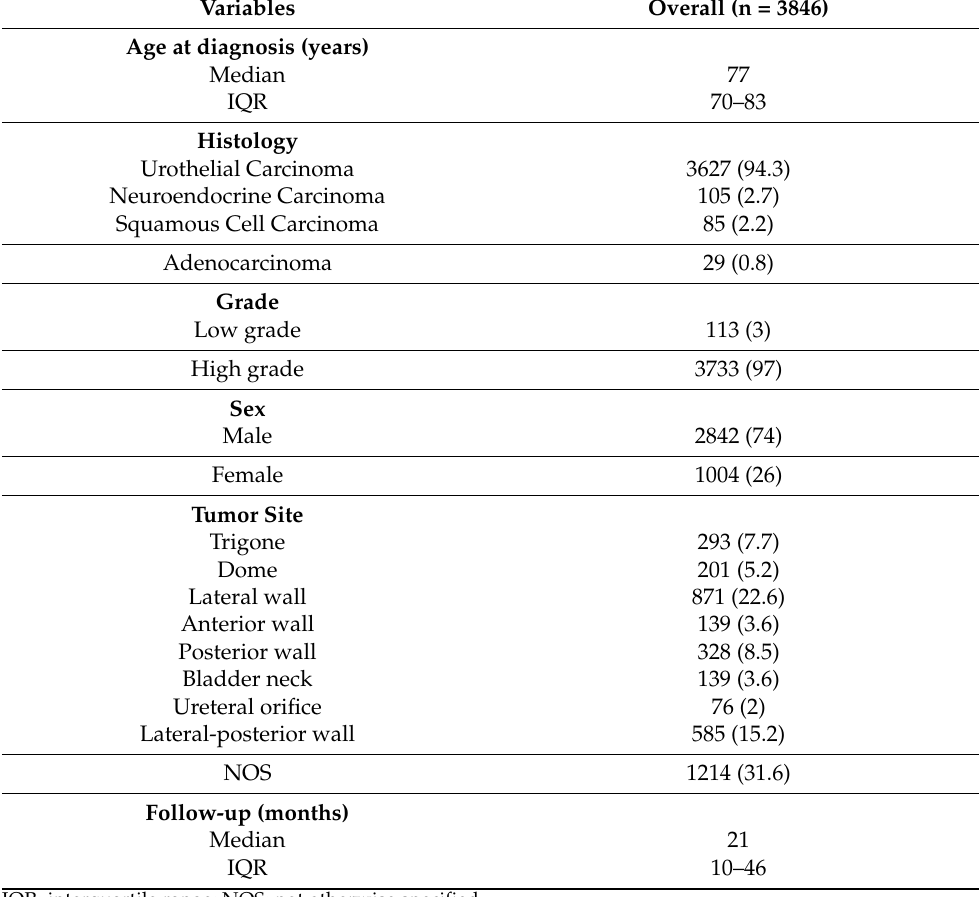
Table 1. Descriptive characteristics of 3846 T2N0M0 bladder cancer patients treated with trimodal therapy identified within the Surveillance, Epidemiology, and End Results database